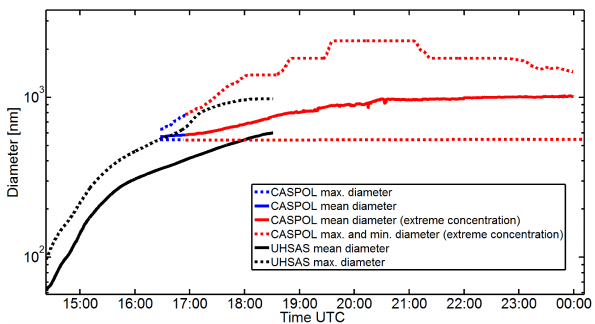
Figure 5. SOA growth over a 10h period, 1Hz sampling rate (Run no. 1516). CASPOL and UHSAS overlapped size measure- ments. Black lines – particles measured with UHSAS, instru- ment’s cut-off is at 1000nm. Blue lines – particles measured with CASPOL. Red lines indicate that CASPOL has passed the satura- tion threshold and the measurements may be subject to coincidence